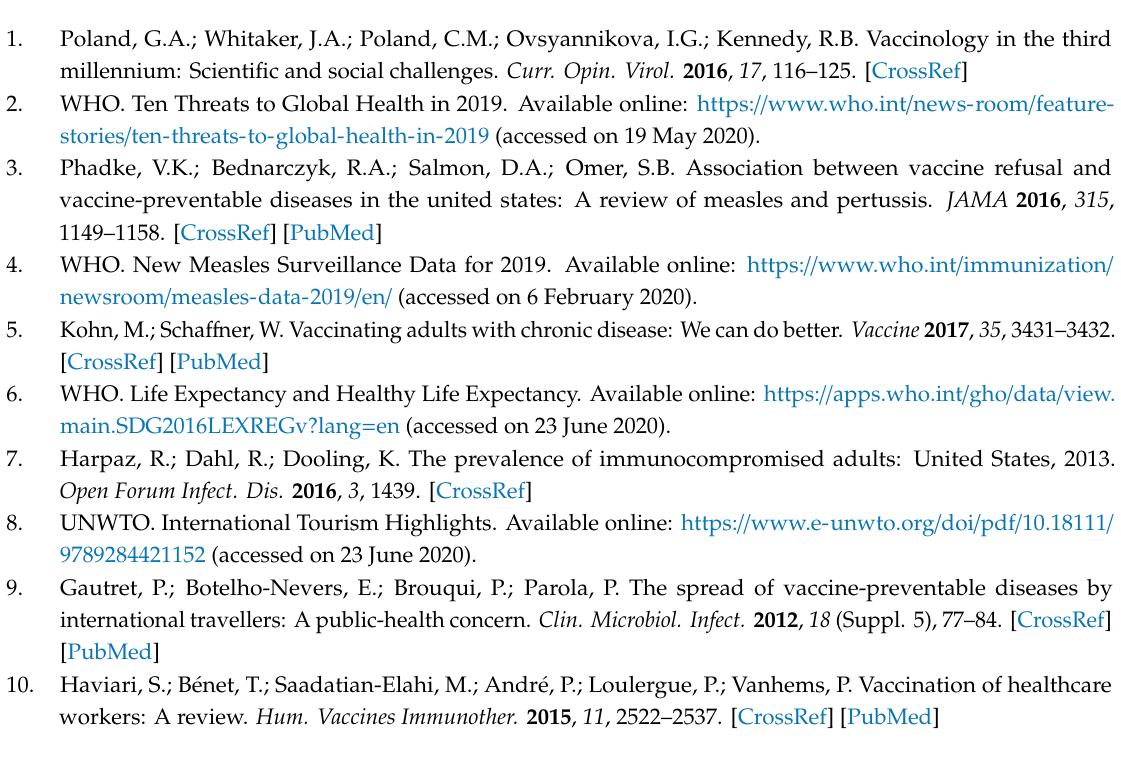
Table S1: Health behaviour theories on the basis of the I-Change model; Table S2: Quality assessment of included articles, Supplementary File S1: Search strings